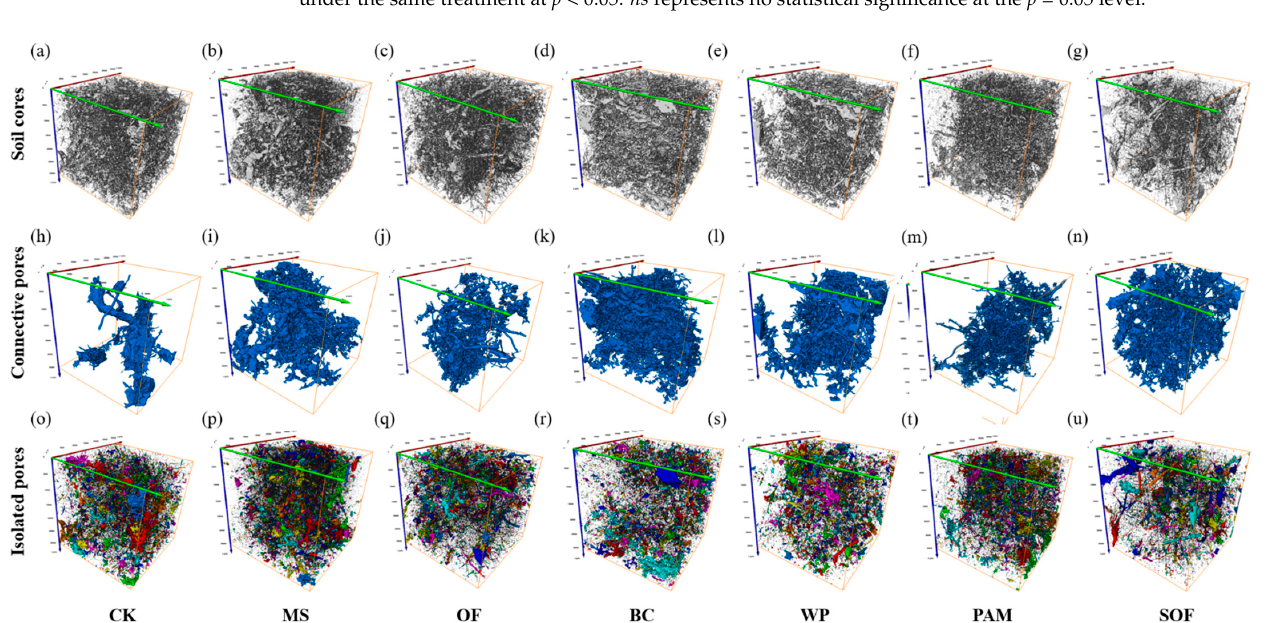
0.01 Data for 2020 are cited from Xuan et al. [27] . Different lowercase letters within a row indicate significant differences among treatments, and * indicates significant differences between two years with different rainfall conditions under the same treatment at p < 0.05. ns represents no statistical significance at the p = 0.05 level. Compared to 2020, after extreme rainfall, all the parameters showed highly significant changes except for the percentage of each pore shape. Among them, the total porosity, connected porosity, and C/I ratio decreased by 58.40%, 68.06%, and 84.74% on average, respectively, while the isolated porosity increased by 76.52%. It is clear from the ANOVA results that organic management, extreme precipitation, and their interactions can affect the C/I ratio. In terms of pore shape parameters, rainfall can reduce the fraction of regular pores and increase the fraction of irregular pores, but no significant difference was observed. Overall, soil porosity was significantly reduced when placed under